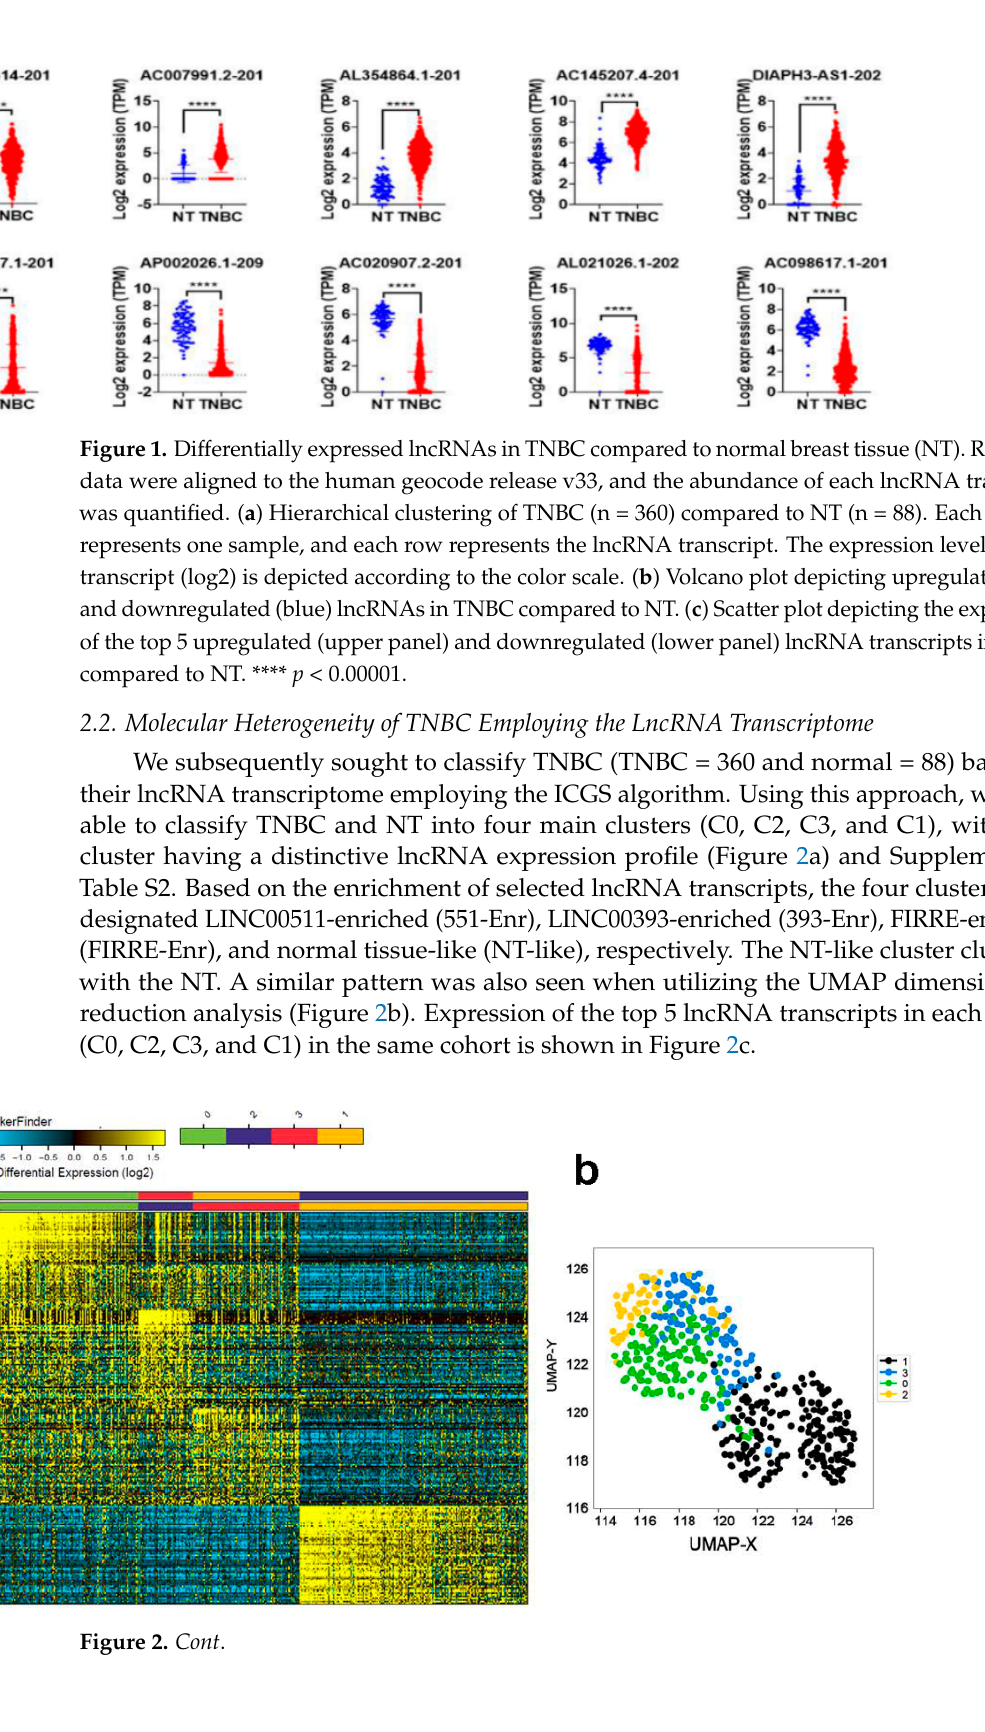
Figure 2. Molecular heterogeneity of TNBC employing lncRNA transcriptome. ( a ) Iterative cluster- ing and guide − gene selection (ICGS) classification of TNBC and NT based on their lncRNA tran- scriptome, revealing four distinct clusters. ( b ) Uniform manifold approximation and projection (UMAP) dimensionality reduction analysis of TNBC and NT based on their lncRNA expression. ( c ) Scatter plot depicting the expression of the top 5 enriched lncRNA transcripts in each cluster (C0, C2, C3, and C1) in the same cohort. 2.3. Functional Heterogeneity of TNBC Employing LncRNA-Based Clustering We subsequently divided the cohort into four groups based on their lncRNA classi- fication and identified their corresponding protein-coding transcriptomes. Employing the marker finder algorithm, we observed significant differences in the enriched gene ontol- ogy (GO) annotations associated with each TNBC cluster (Figure 3a) and Supplementary Table S3.